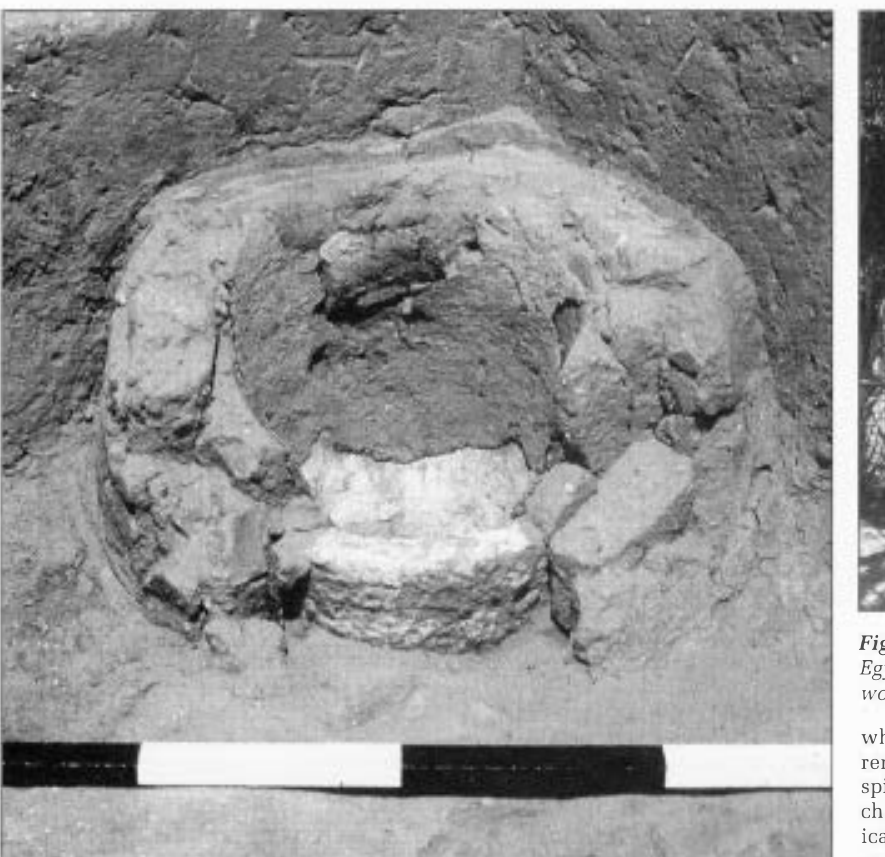
Figure 5 A limestone mortar with a built-up mudbrick and plaster rim, placed in the corner of a village house at Amarna (scale bar intervals 25